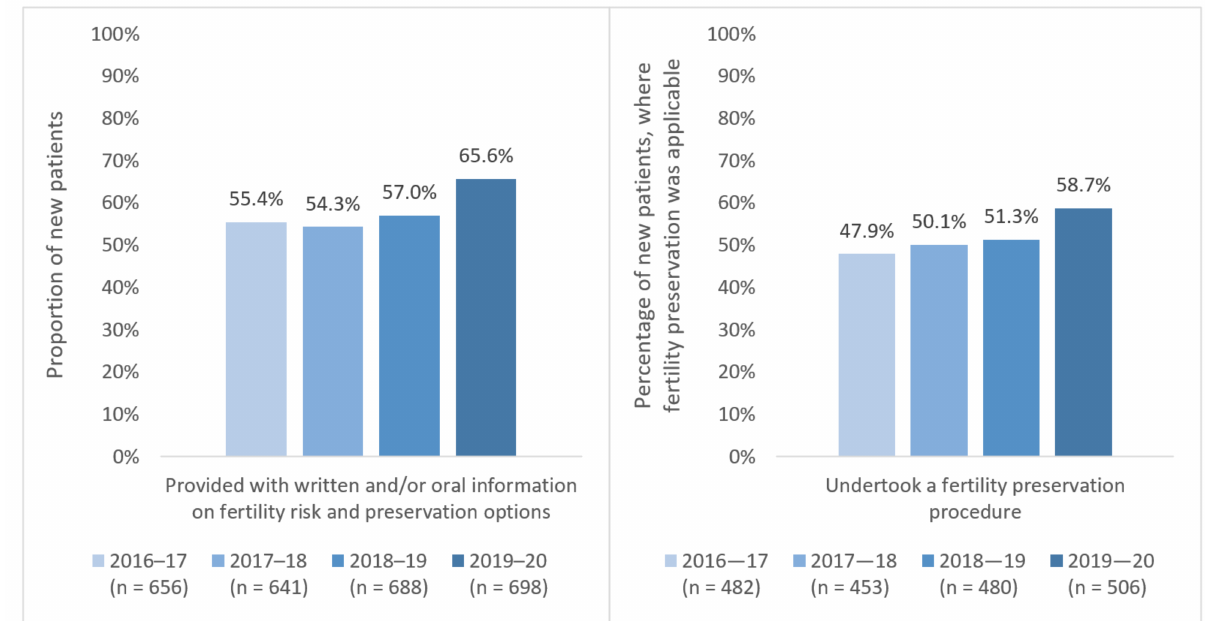
Figure 2. YCS activity data on oncofertility care, 2016–17 to